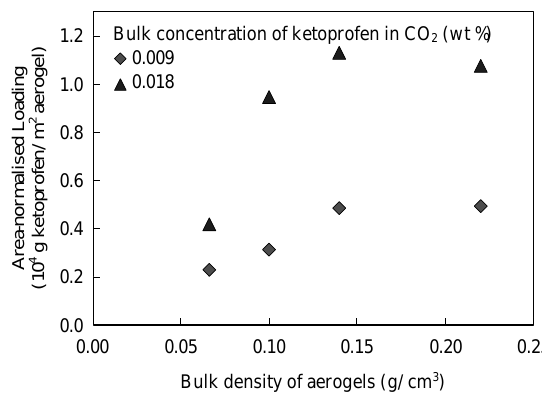
Adsorption of ketoprofen on hydrophilic aerogels: (A) Loading as a function of density; (B) Loading as a function of aerogels’ surface area; (C) Area-normalized loading as a function of density of the aerogel